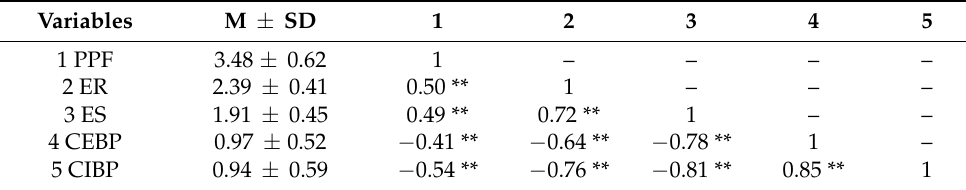
Table 1. Descriptive statistics and association analysis among